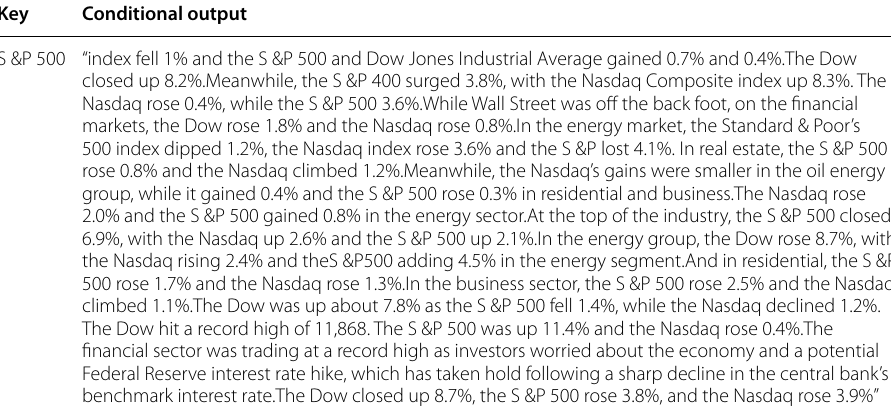
Table 5 Results of interactive conditional samples